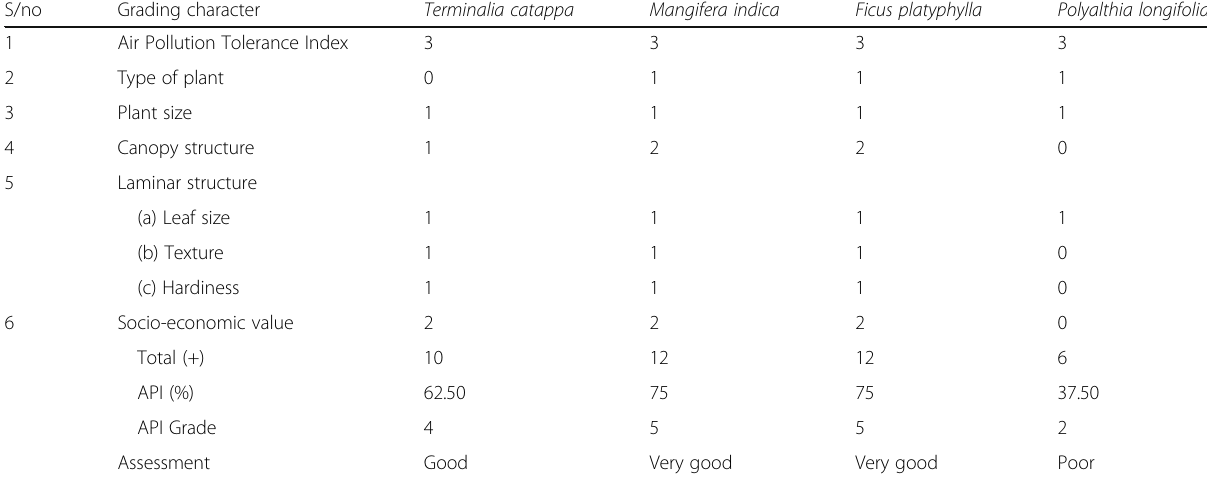
Table 11 Evaluation of tree species gradation based on APTI, morphological parameters and socio-economic